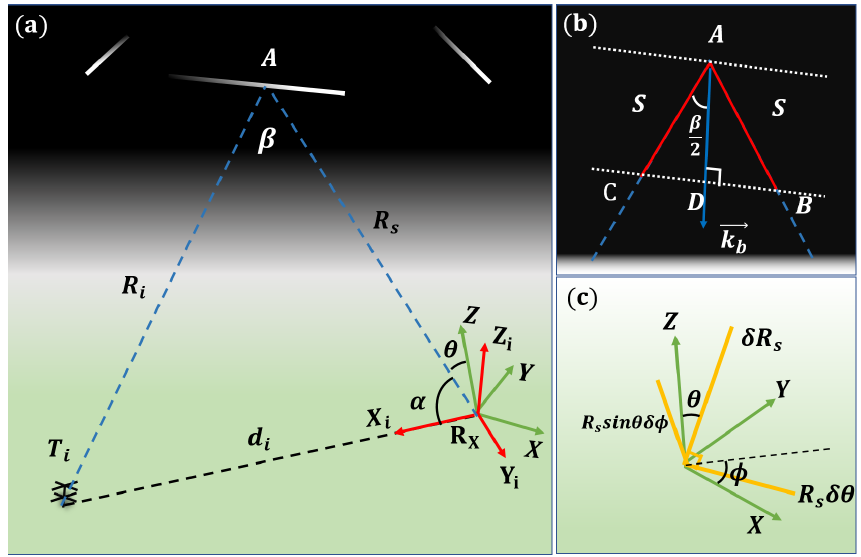
Figure 4. (a) Schematic diagram of the forward-scatter geometry for the radar link between T i and R X . Point A is the MTSP. (b) Magnified plot of specular point A. The red line represents a radio wave pulse, and S is the half-pulse length. k b is the Bragg vector, which halves the forward-scatter angle β . (c) Schematic diagram of E 1 in XYZ , which can be decomposed into three orthogonal